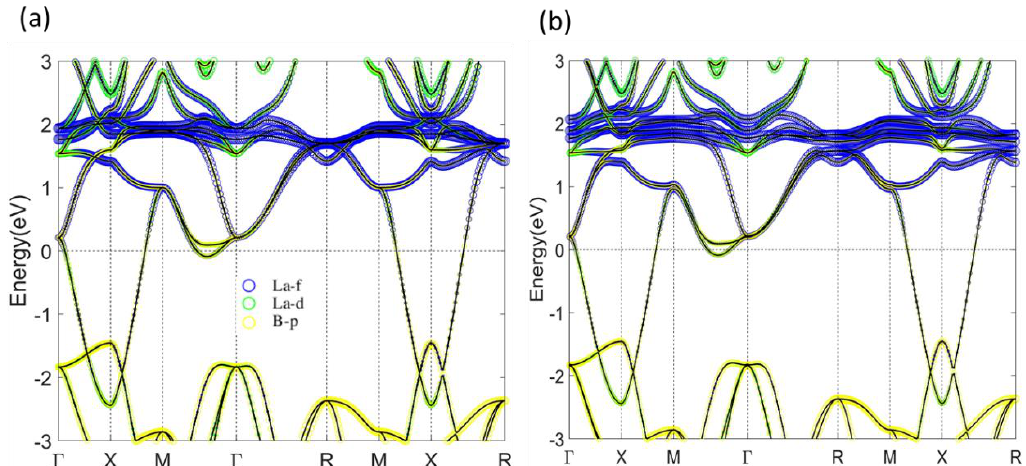
Figure 2. Atom-orbital decomposed band structure of LaB 6 calculated using Perdew–Burke–Ernzerhof (PBE) functional without spin–orbit interaction (SOI) ( a ) and with SOI ( b ). The size of blue, green and yellow circles indicates components from La-f, La-d and B-p orbitals, respectively.